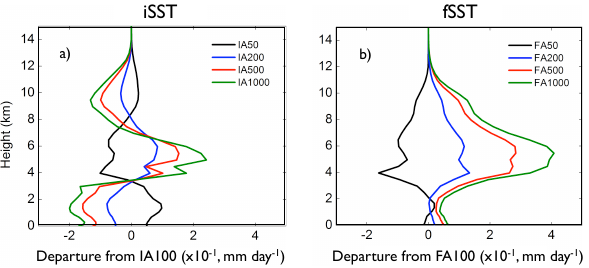
Fig. 7. Vertical profiles of the departures from the control (IA100 and FA100) of precipitation flux, 10–1mmday − 1 1 for (a) interac- tive and (b) fixed